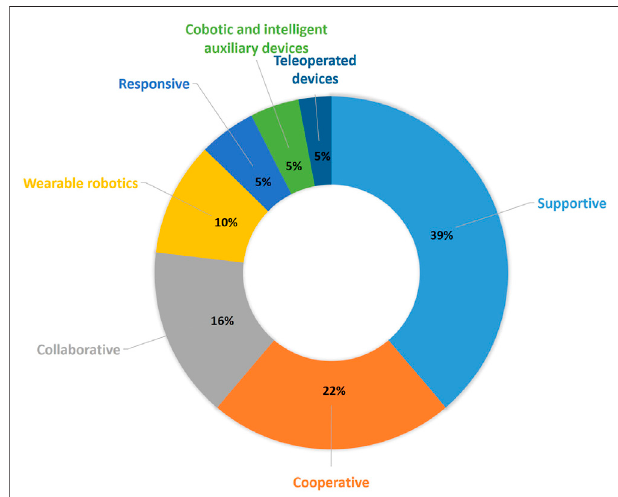
FIGURE 8 | Percentage of project per each category of the technical classi fi